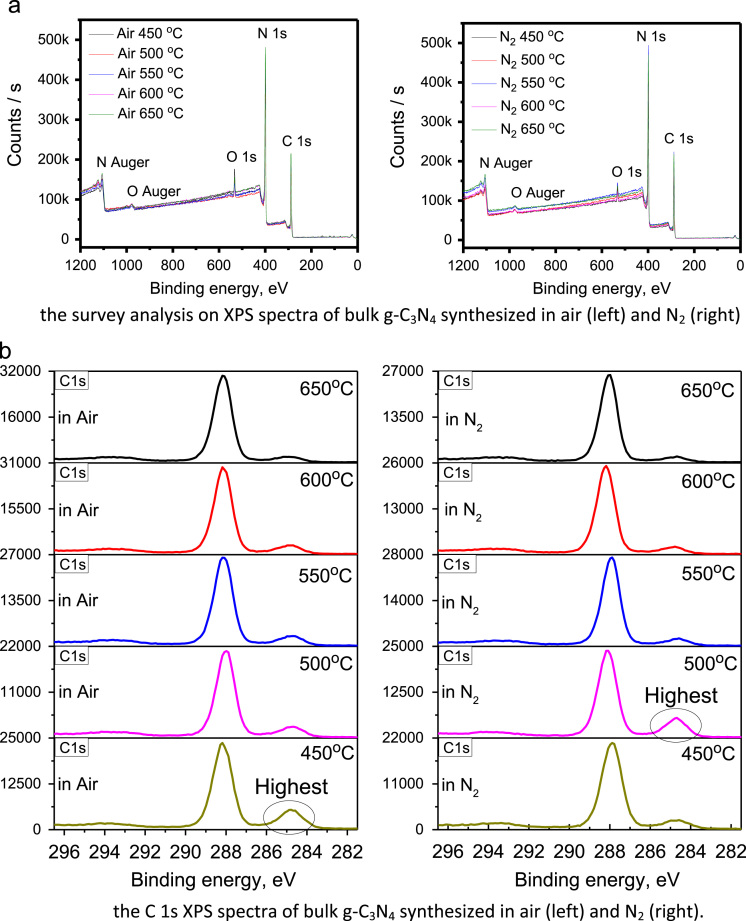
The survey, C 1s, N 1s, and O 1s XPS spectra of bulk g-C3N4 powders synthesized at variant temperatures in air and N2, respectively.